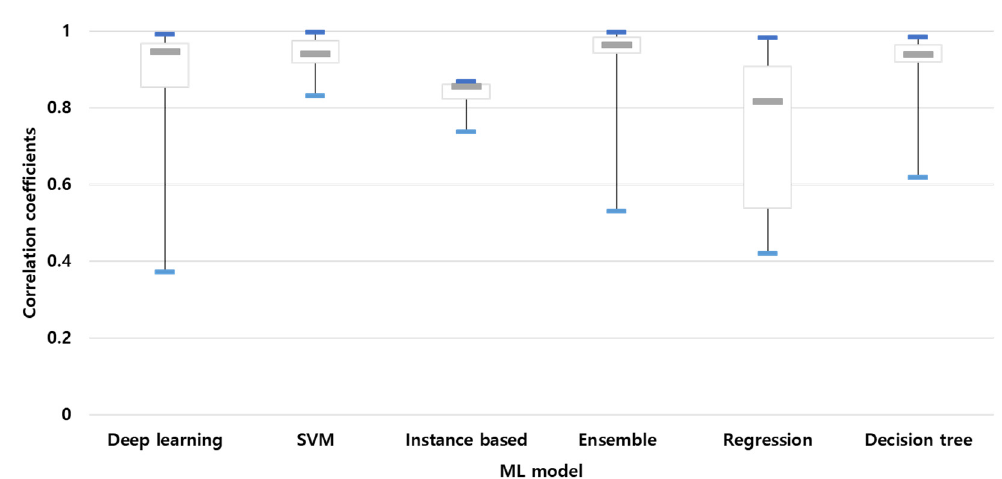
Figure 14. Box plots for R.